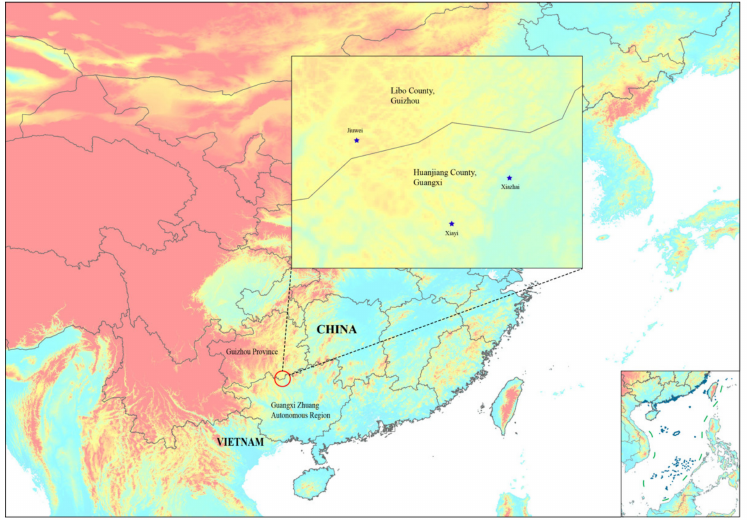
Figure 5. Distribution records of Smilax weniae P. Li, Z.C. Qi & Yan Liu. sp. nov. (blue stars) from Libo County, Guizhou Province, and Huanjiang County, Guangxi Zhuang Autonomous Region,